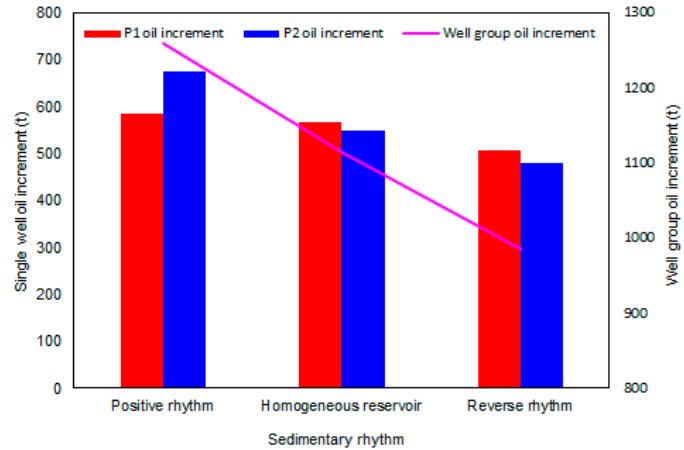
Figure 8. Oil increment of different sedimentary rhythms and well types.